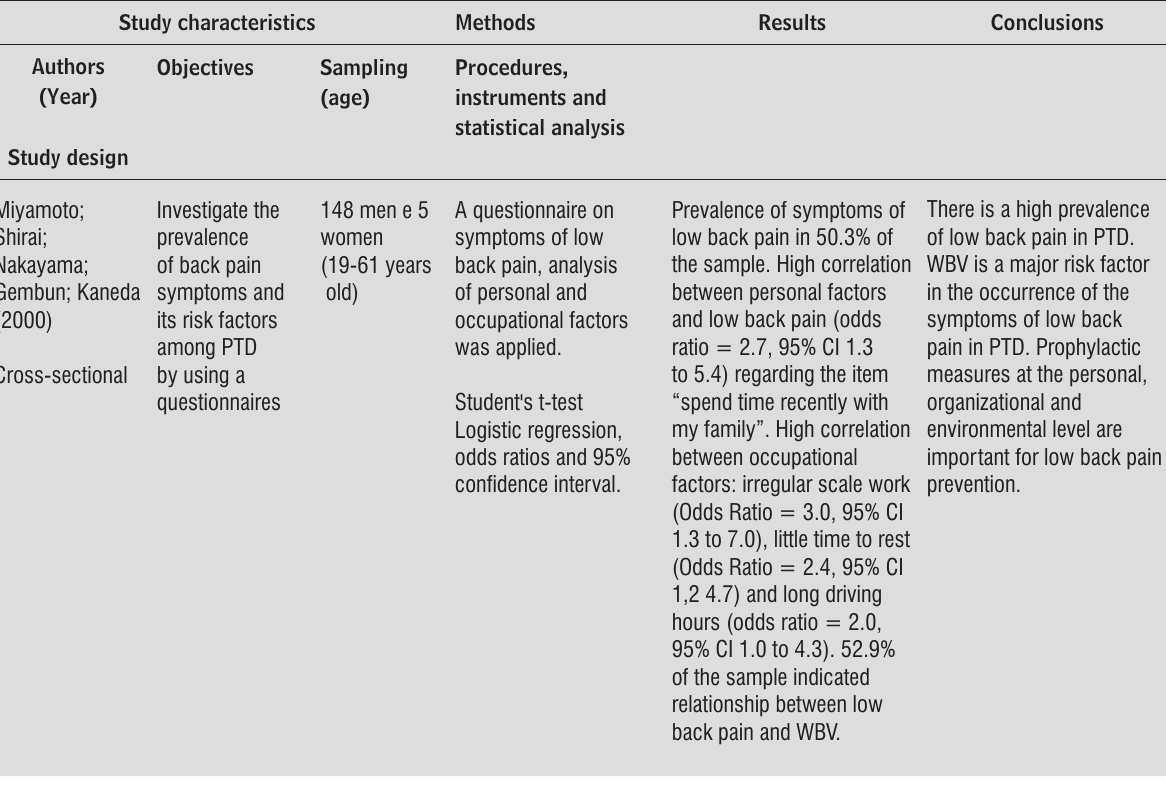
Table 3 - Characteristics of the articles selected for systematic